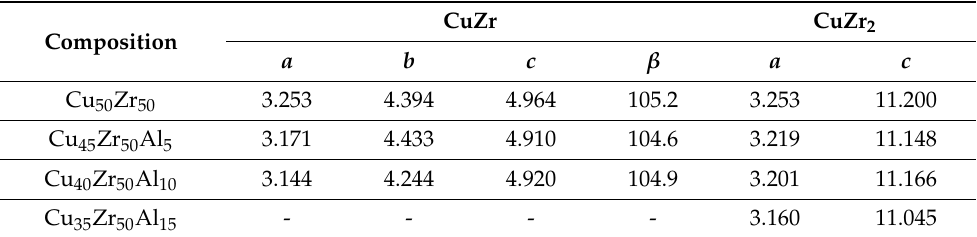
Table 2. Lattice parameters (Å and ◦ ) of martensite CuZr ( P 2 1 / m ) and CuZr 2 as a function of Al content. Uncertainties are estimated to be 0.005 Å and 0.2 ◦